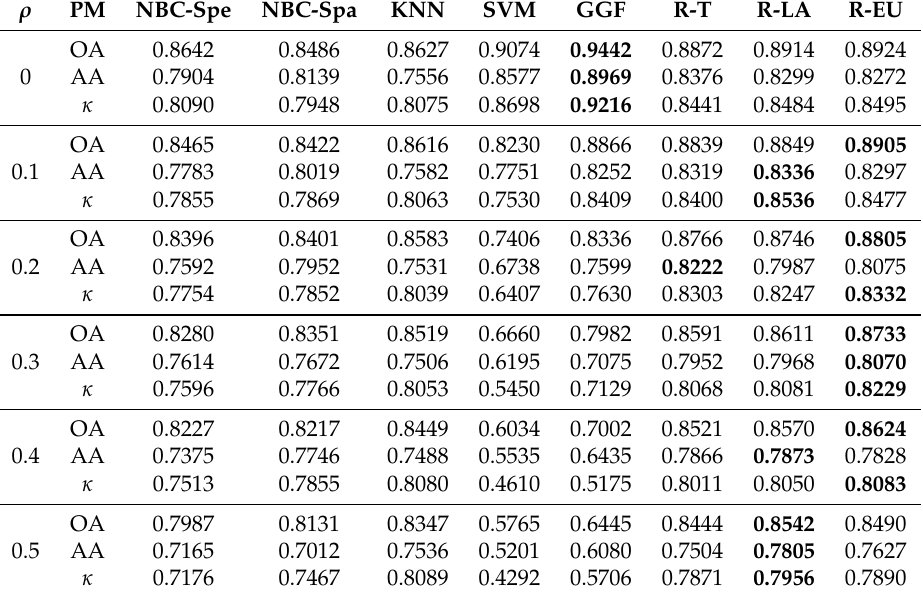
Table 5. Classification results for the HYDICE Urban data set with different classifiers.